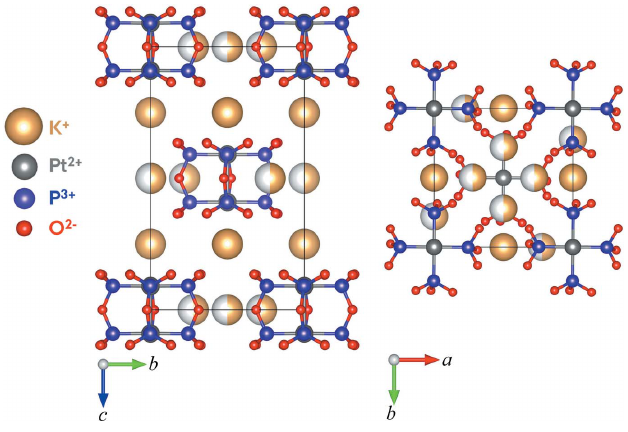
Figure 12 I 4/ m structure of K 4 [Pt 2 (P 2 O 5 H 2 ) 4 ] (cid:2) 2H 2 O determined from the SACLA data. Water molecules and hydrogens have been